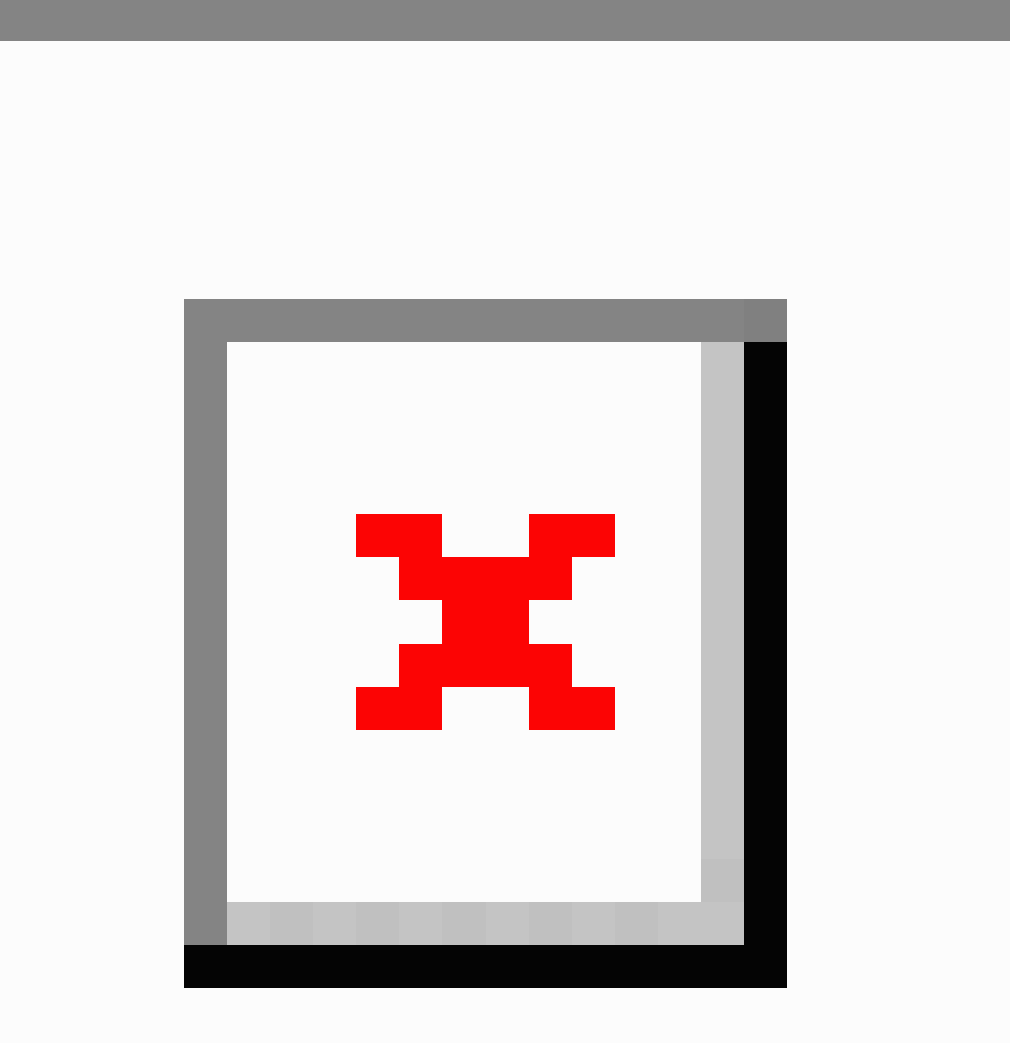
Figure 11. Boxplots of the distributions of the marginal means for participant age. The under-25 use the Fitbit less long than the other groups. There are no participants older than 65 in this